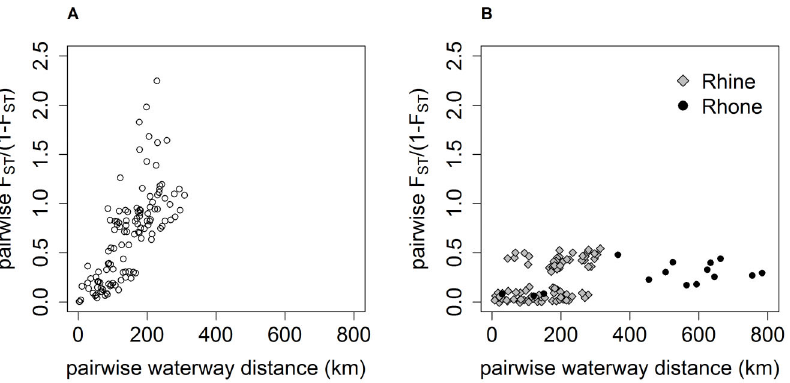
Figure 3. Isolation by distance plots for G.fossarum type A (left) and type B (right). Only data for the Rhine drainage are shown for type A. For type B, data for the Rhine (grey diamonds) and Rhone (black circles) are shown. The relationship was significant in Mantel tests for type A (P=0.0001) as well as type B in the Rhone (P=0.0191), but not for type B in the Rhine (Table 1). Slopes are significantly different between species as indicated by non-overlapping 95% confidence intervals (Table 1). For type B in the Rhine drainage, the group with a higher degree of differentiation (F ST /(1-F ST ) . 0.3) contains pairs of populations from the two distinct clusters B1 and B2 (Fig. 2).